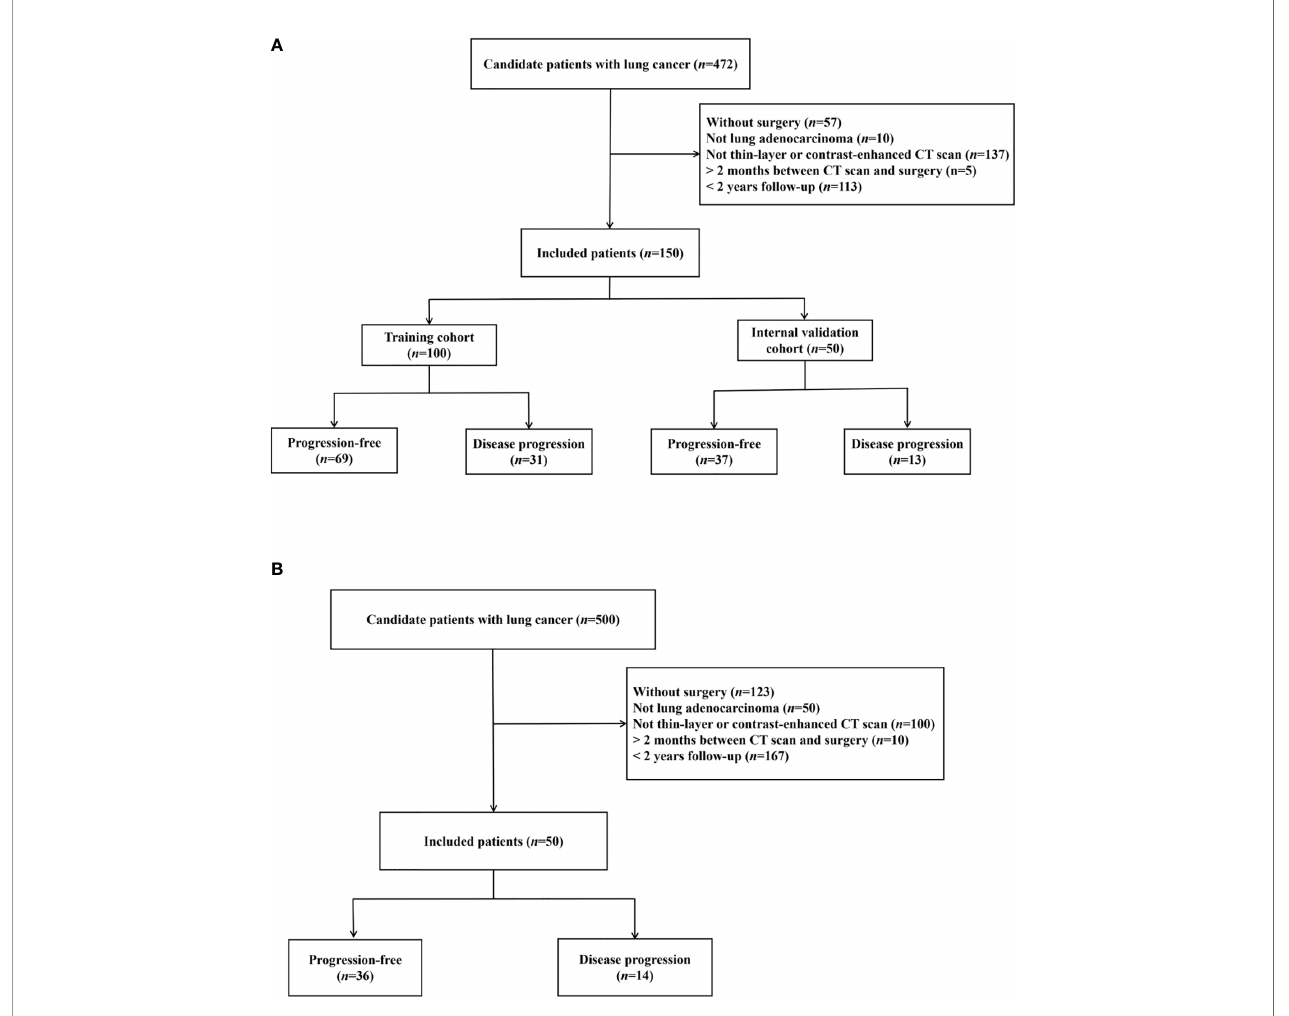
FIGURE 1 | Patient inclusion fl owcharts in two hospitals. (A) Hospital-1 (training and internal validation). (B) Hospital-2 (external